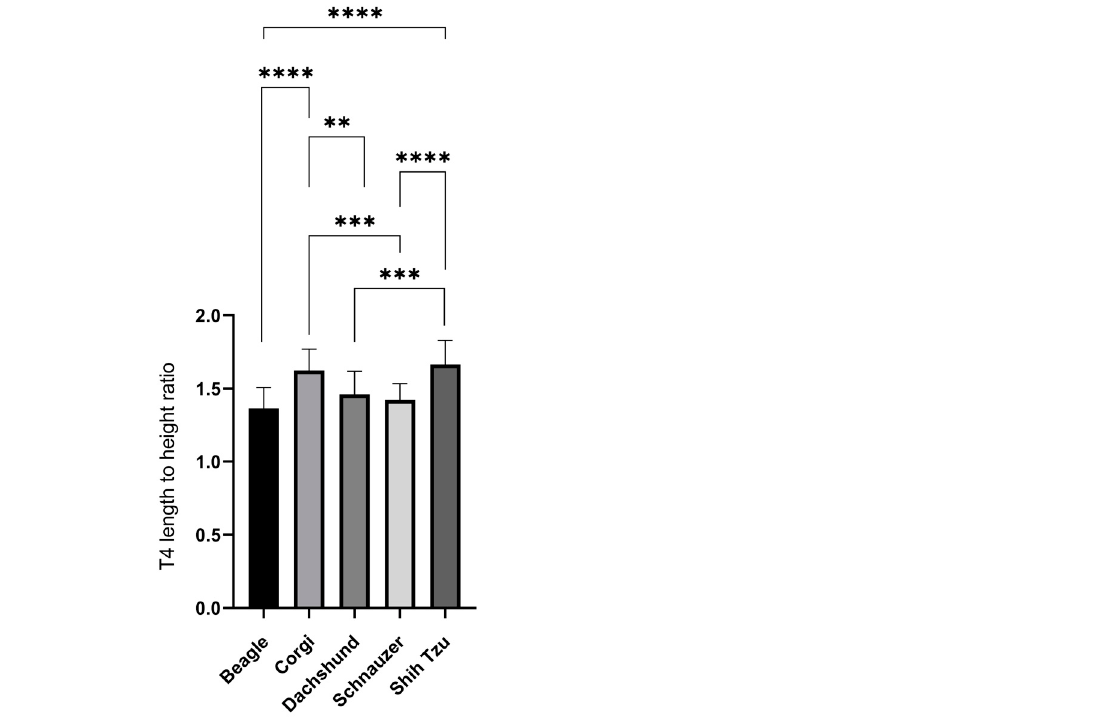
Figure 2. The length-to-height ratio of the fourth thoracic vertebrae among Corgis, Shih Tzus, Schnauzers, Beagles, and Dachshunds. Data were expressed as mean ± SEM. ** p < 0.01; *** p < 0.001; **** p < 0.0001.